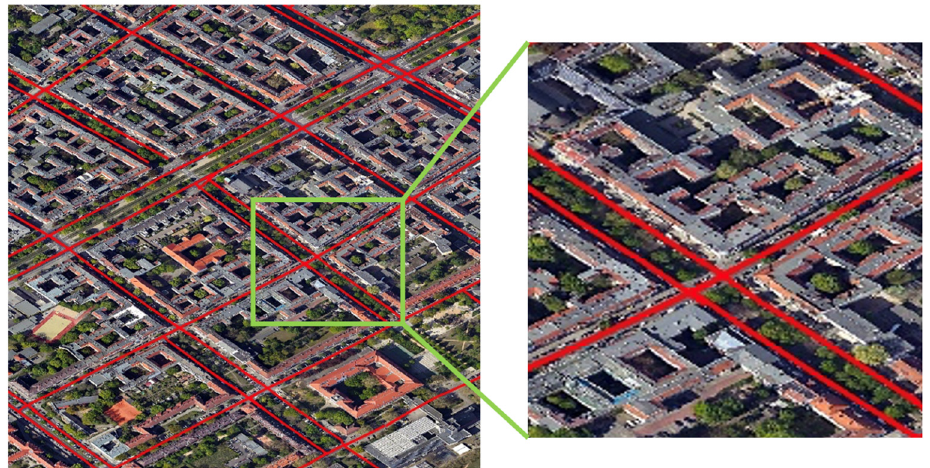
Figure 14. Visualization results of the proposed Bi-HRNet on the vegetation-covered area of the constructed Google dataset. constructed Google